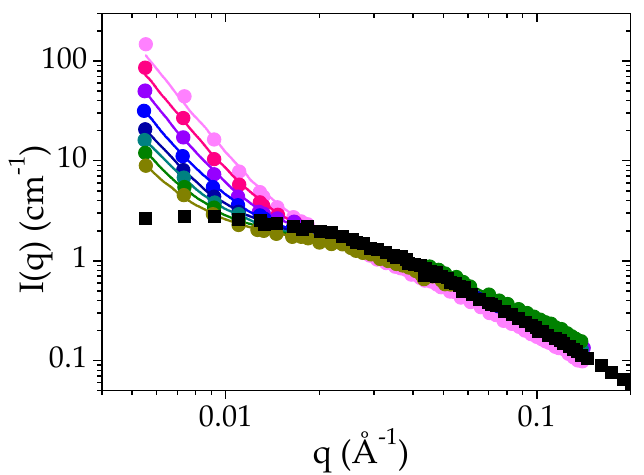
Figure 4. Time evolution of the SANS intensity as a function of q for a solution of PMAA at a volume fraction of 0.065 after a temperature jump from 25 ◦ C to T cp + 1 ◦ C: 60 min • , 180 min • , 300 min • , 420 min • , 520 min • , 660 min • , 780 min • and 900 min • . solid lines correspond to the fit of the experimental data to Equation (3). The I ( q ) curve recorded for the same solution at 25 ◦ C is also plotted for the sake of comparison ( ■ ).